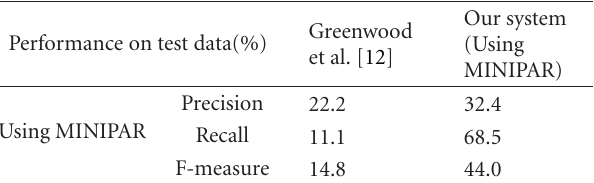
Table 4: Performances of our system and other previous systems using MINI-PAR.